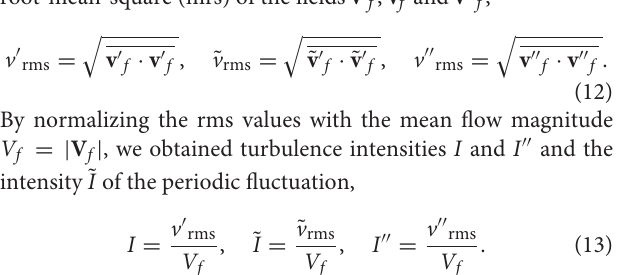
FIGURE 4 | AR and valve model immersed in the fluid domain of size 45 × 45 × 97.5mm with periodic boundary conditions in all spatial directions. The magenta shaded area indicates where a forcing term was applied.